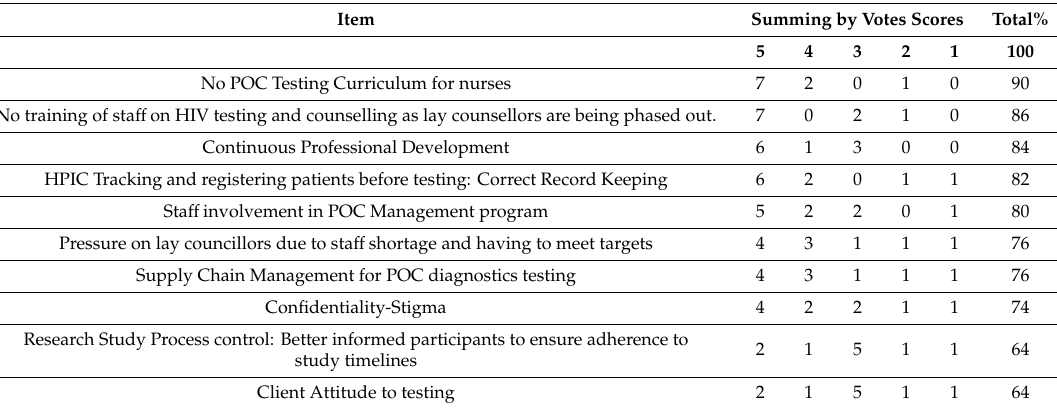
Table 2. Ranking results in descending